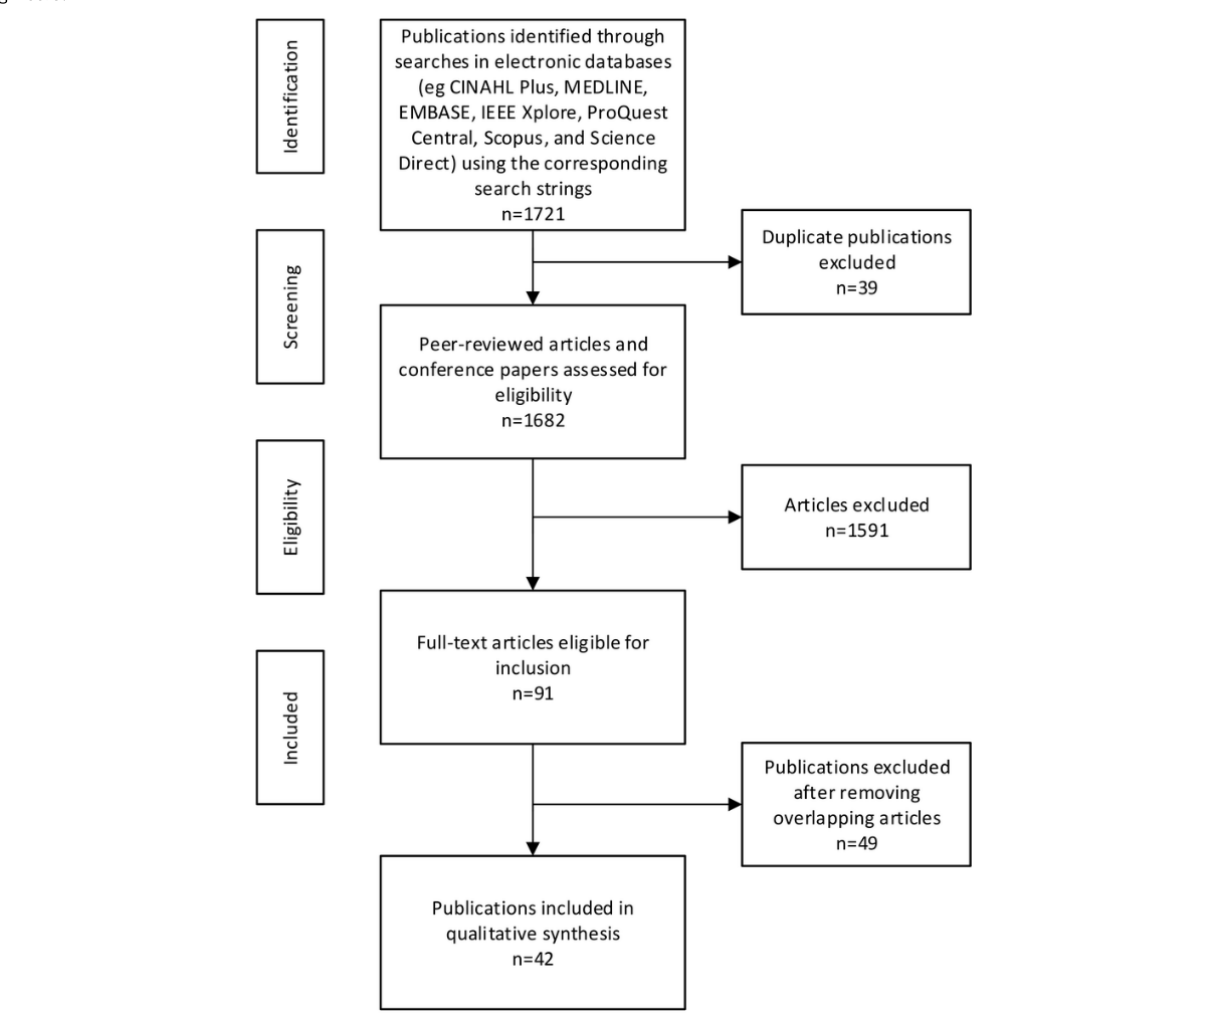
Figure 1. Search methodology. CINAHL: Cumulative Index to Nursing and Allied Health Literature; IEEE: Institute of Electrical and Electronics